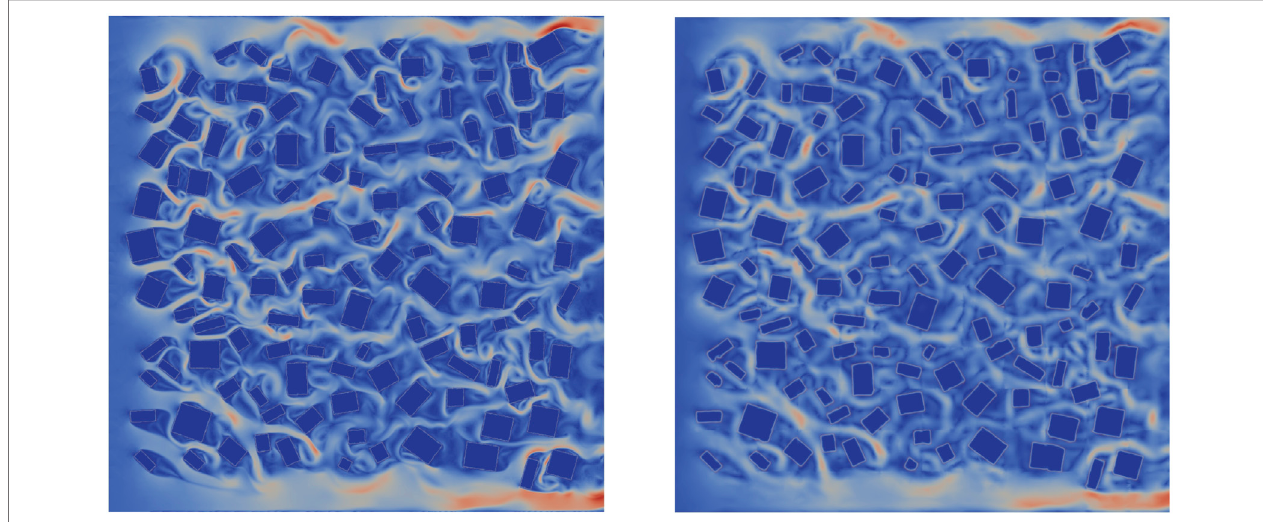
FIGURE 6 | The velocity magnitude at the 350th time level from the HFM (left) and the predictive adversarial network (right).